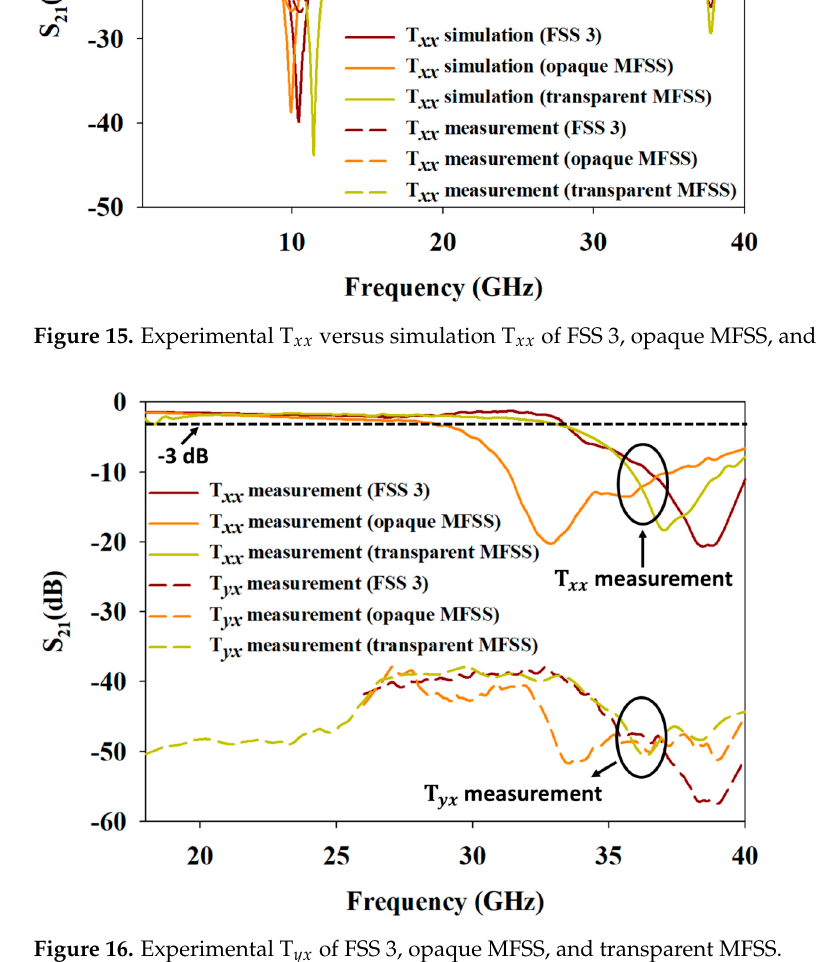
Figure 16. Experimental T (cid:3052)(cid:3051) of FSS 3, opaque MFSS, and transparent MFSS.